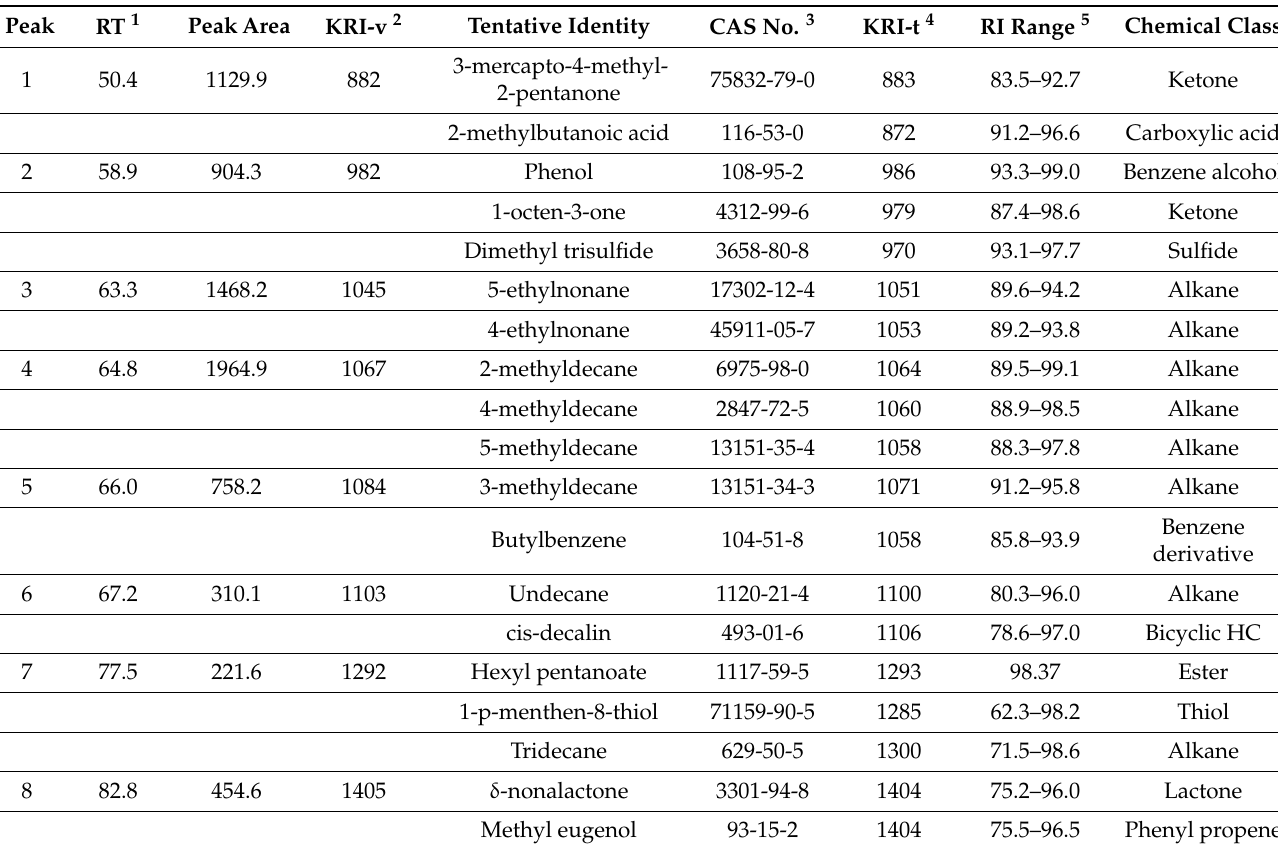
Table 3. Gas chromatographic data indicating the tentative identities of whole-body VOC-metabolite emissions associated with major peaks derived from inactive Pd-infected (symptomatic WNS- diseased), intracave tricolored bats (n = 9, N =